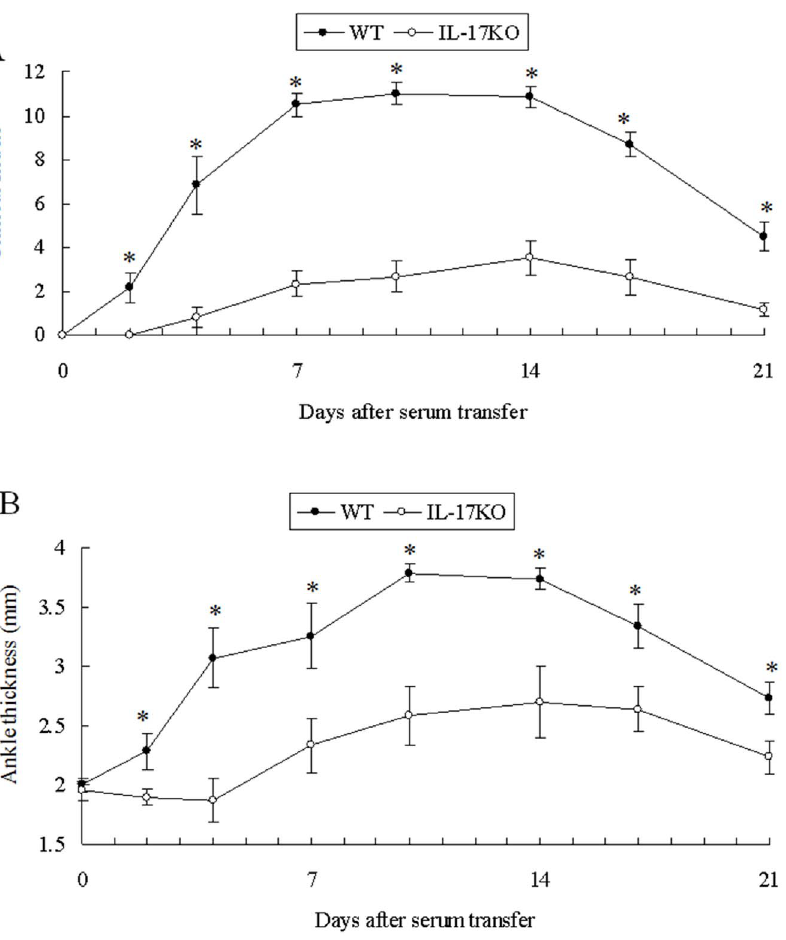
N Figure 1. K/BxN serum-induced arthritis in IL-17 knockout mice. K/BxN sera (200 m l/body) were i.p. injected at days 0 and 2 into IL-17 KO ( # ) ) (n=6 each). Clinical index (A) and ankle thickness (B) were monitored for 21 days. The results were from two independent and WT mice ( experiments, both of which showed similar results. *p , 0.05.